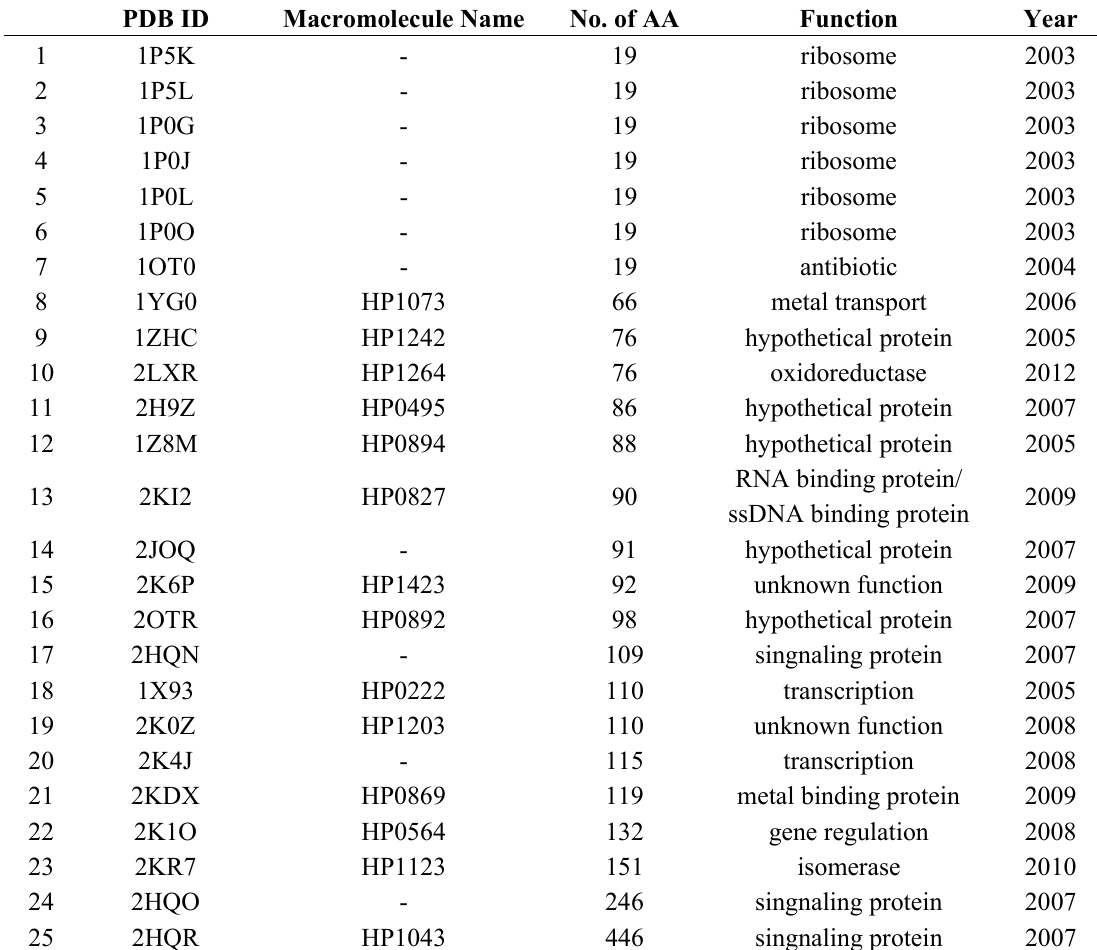
Table 1. Twenty NMR structures of H. pylori proteins. All data were collected from the PDB database on 6 February